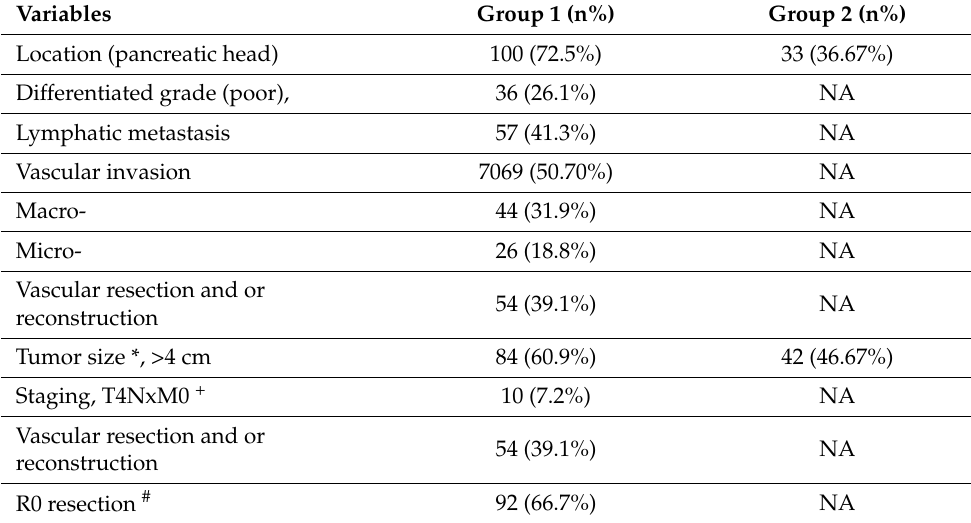
Table 2. Histopathological features of pancreatic